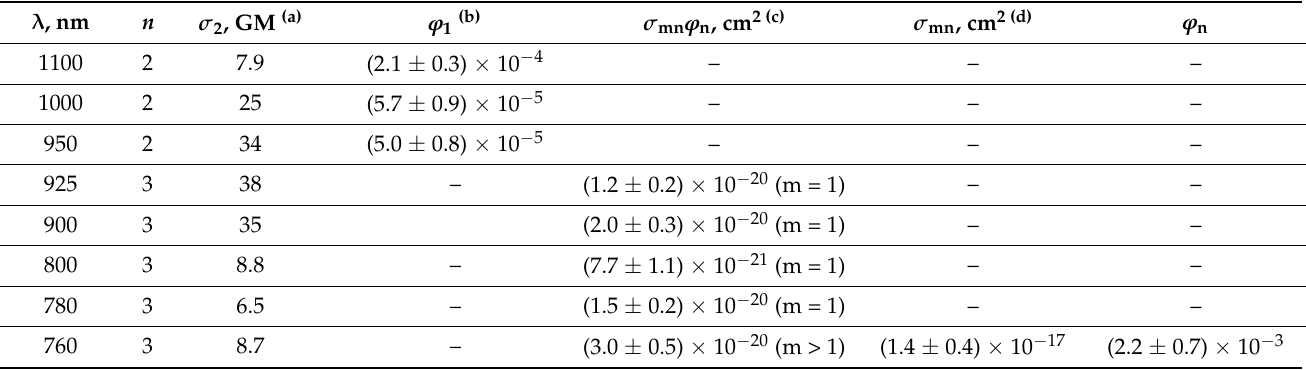
power range below the threshold. (c) Found from the fits of K ( P ) dependences to Function (6). (d) Found from the fits of K ( P ) dependences to Function (7).